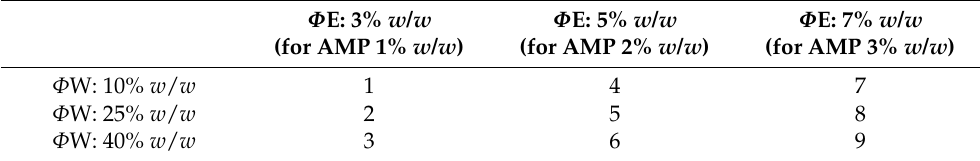
Table 1. Compositions of W/O emulsions used in the present study and their sample codes *. Φ E: 3% w /